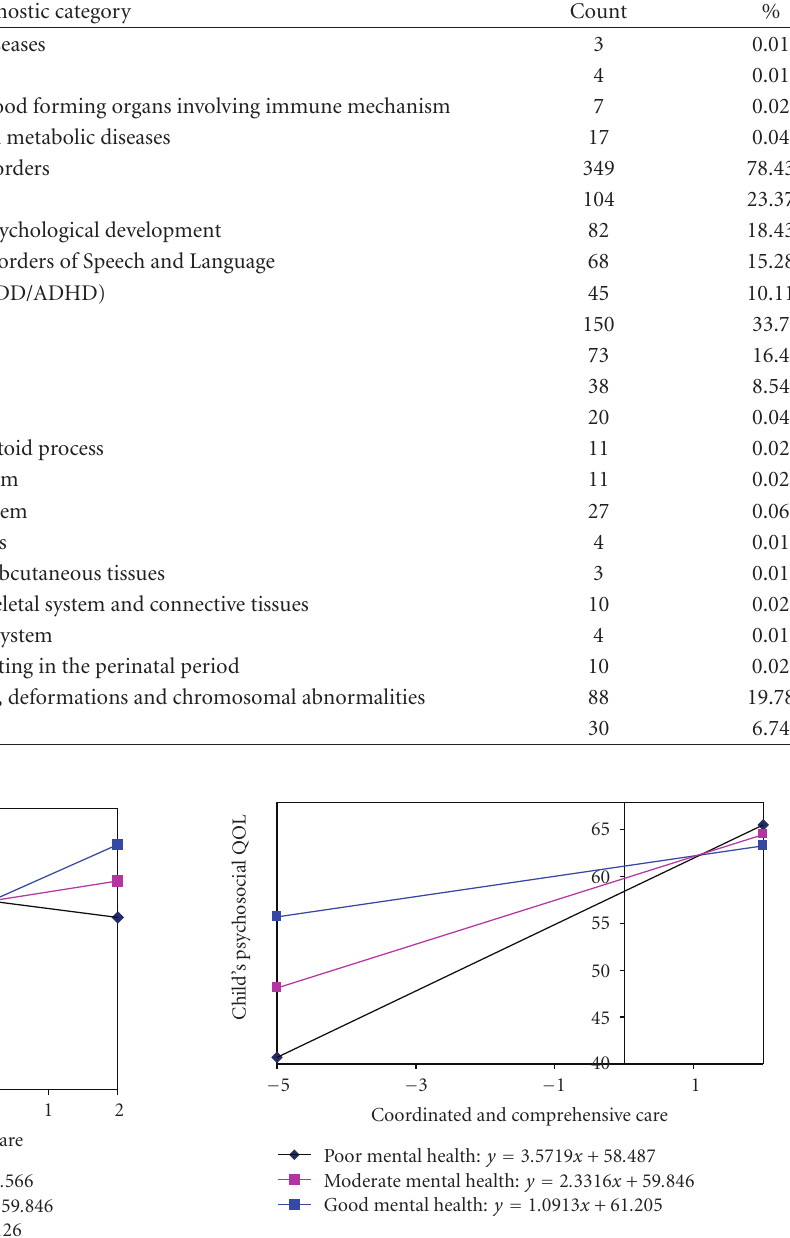
Figure 3: Interaction between Coordinated and Comprehensive Care and PMK Mental